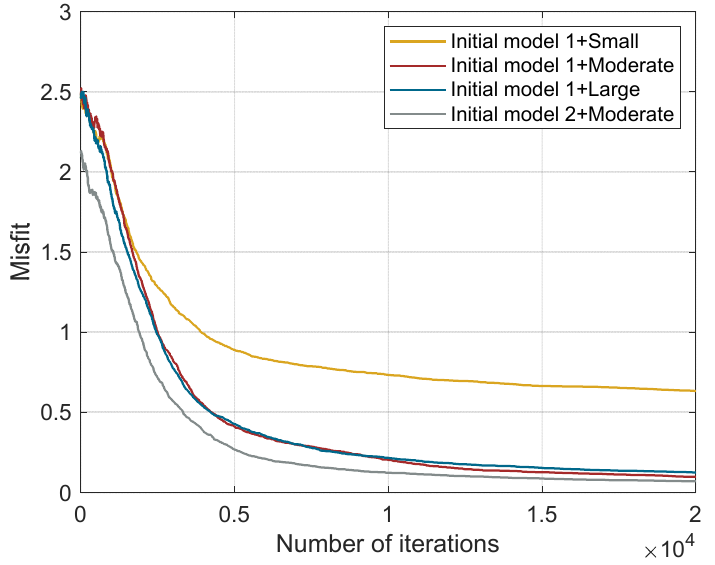
Figure 9. Mis fi ts varying with iteration number at the di ff erent search limits. The de fi nitions of Figure 9. Misfits varying with iteration number at the different search limits. The definitions of curves are given in the legend. curves are given in the